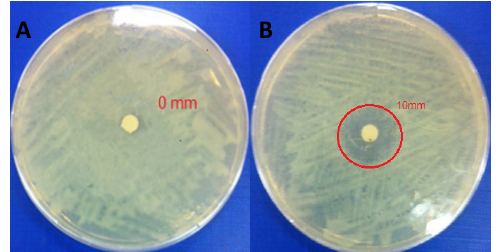
Fig. 11. Antimicrobial activities of (Nylon 6) nanofibers against Escherichia coli. (a) Missing the inhibition zone in plain (Nylon 6), (b) (1.2 %AgNO ), where the inhibition zone is visible in 3 (Nylon 6) embed (AgNPs(AgNO )). 3